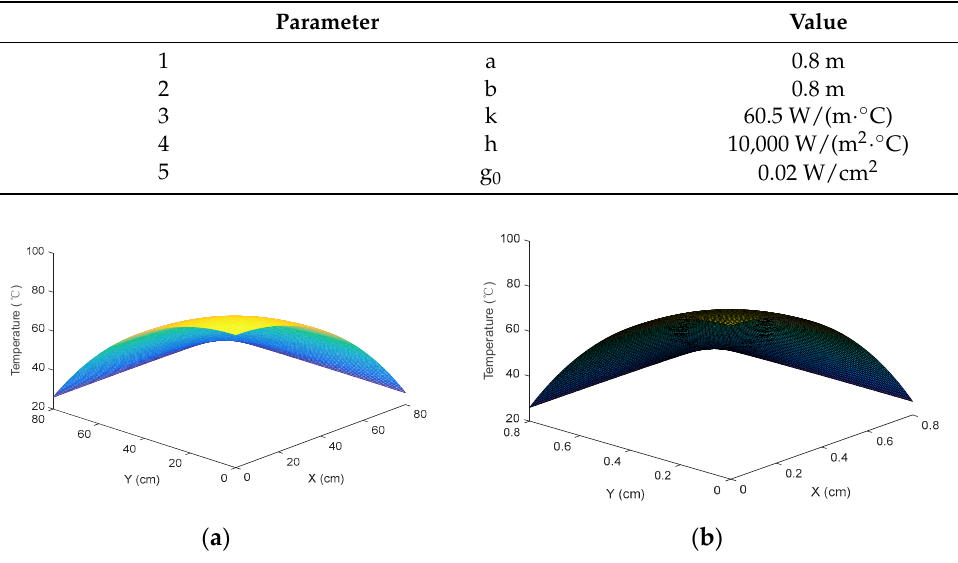
Table 2. Input parameters for steady-state problem of uniform internal heat source.